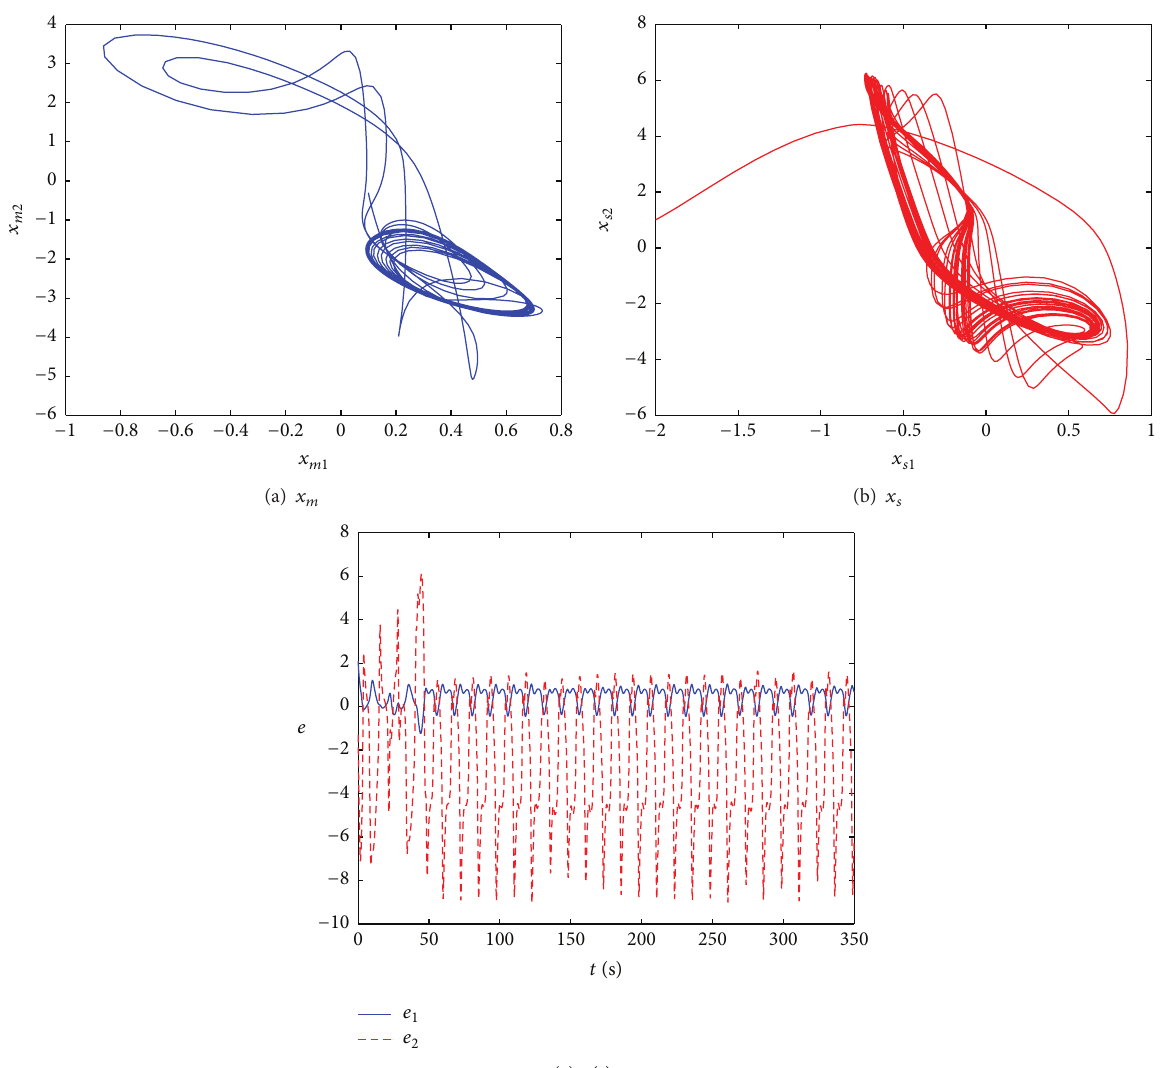
Figure 1: Behavior of the drive and response systems without any control: (a) phase trajectory of drive system, (b) phase trajectory of response system, and (c) synchronization